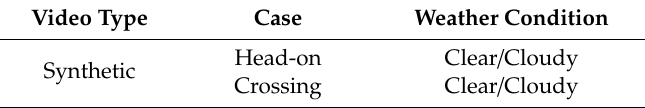
Table 3. Information regarding the synthetic videos.